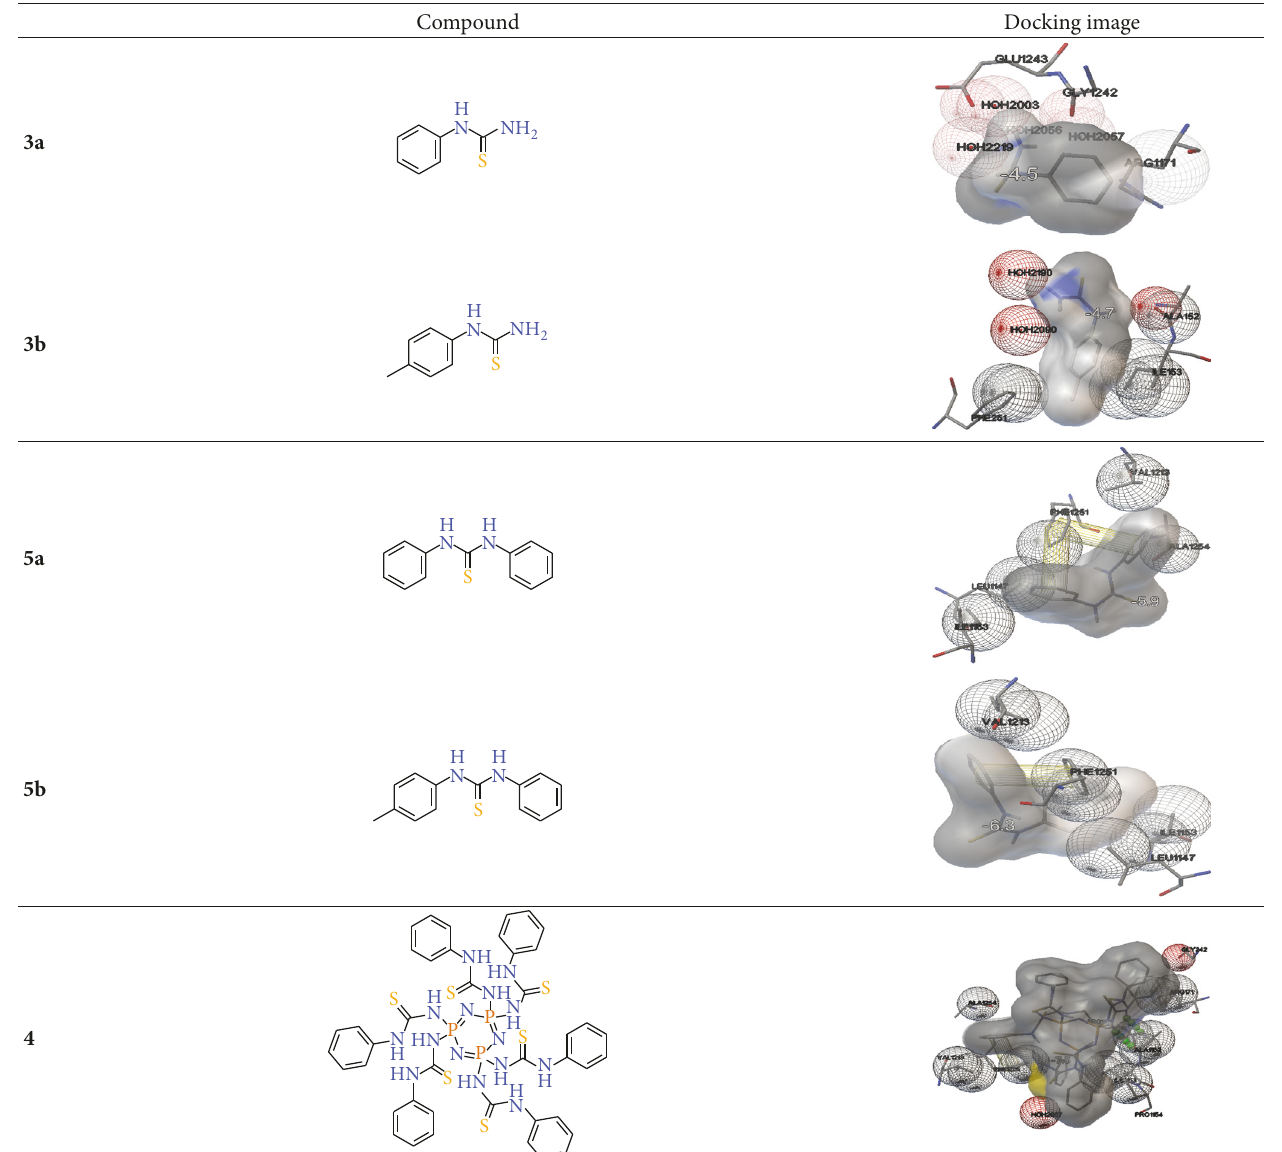
Table 1: Molecular docking images of thiourea